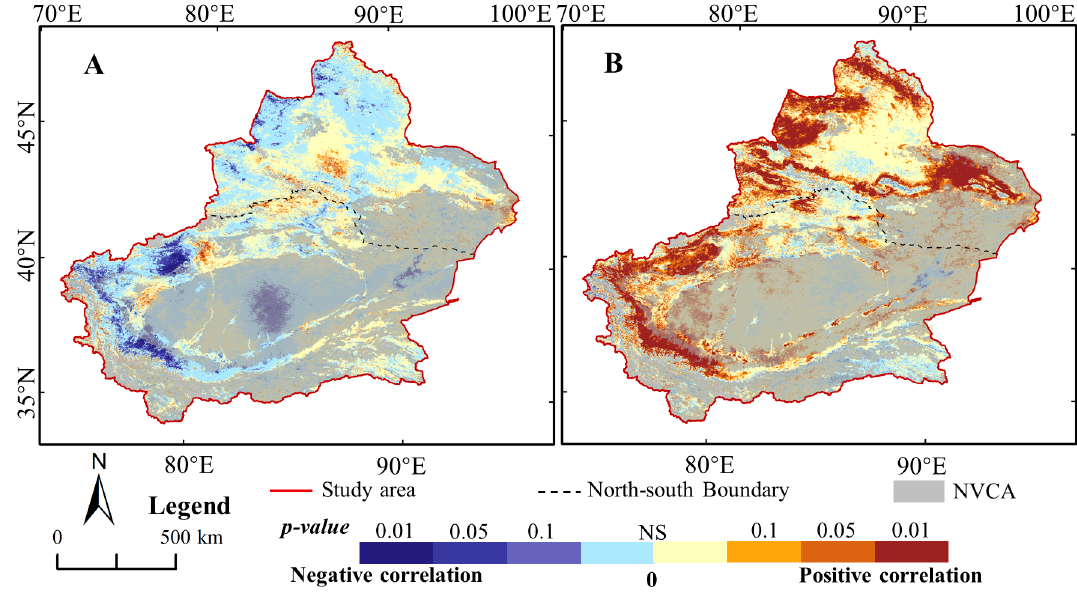
Figure 9. Regional di ff erence of the Pearson correlation coe ffi cients between the GNDVI and climate in growing seasons of Xinjiang. ( A ) and ( B ) denote the temperature and precipitation, respectively. NS denotes the correlation is not significant. The NVCA denotes the non-vegetation covered areas.